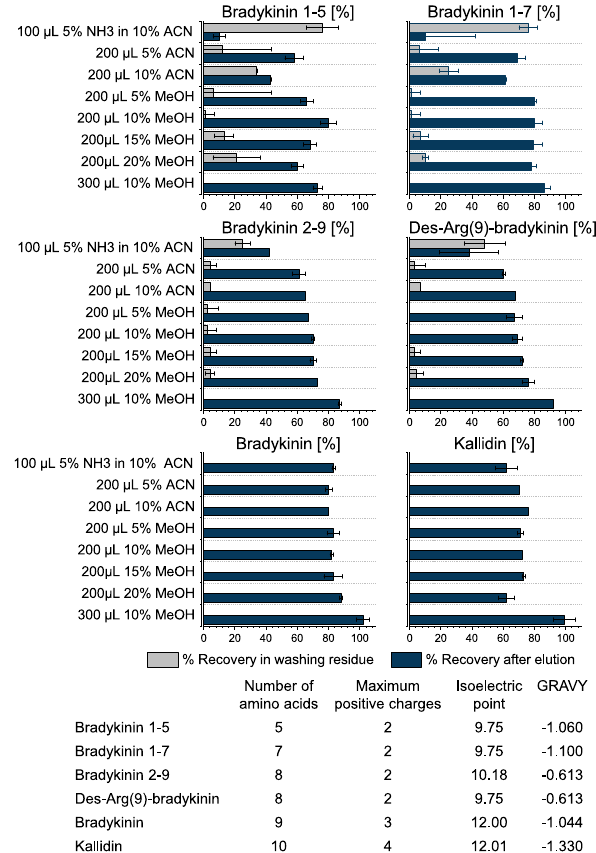
Figure 3. Recoveries during evaluation of washing steps using neat solutions and applying weak cation exchange µelution solid-phase extraction (n = 2). Peptide characteristics were calculated using ProtParam 43 . ACN: acetonitrile, GRAVY: grand average of hydropathicity index, MeOH: methanol, NH 3 : ammonium.